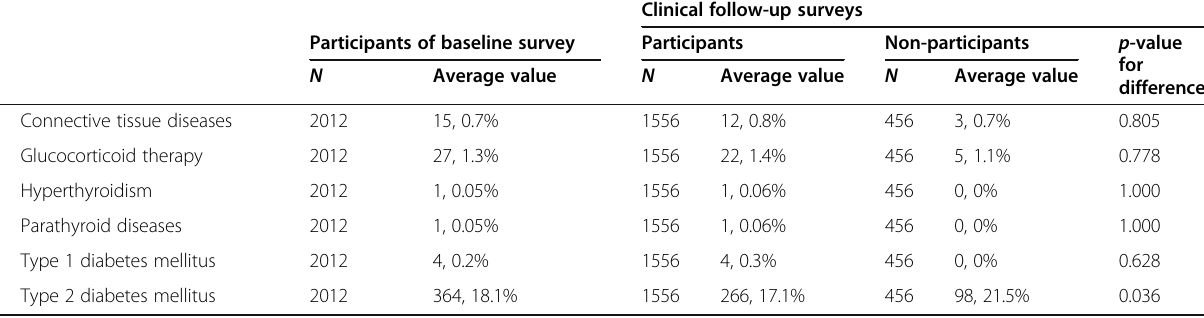
Table 2 Comparison of baseline characteristics between participants and non-participants of clinical follow-up surveys (Continued) Clinical follow-up